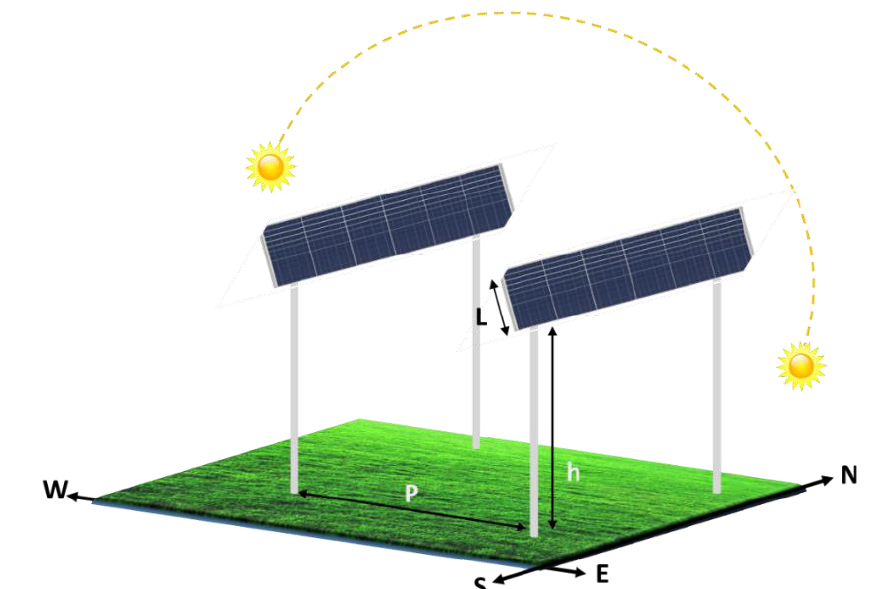
Figure 13. Schematic diagram of a bifacial fixed-tilt agrivoltaic farm. Single Axis Tracking